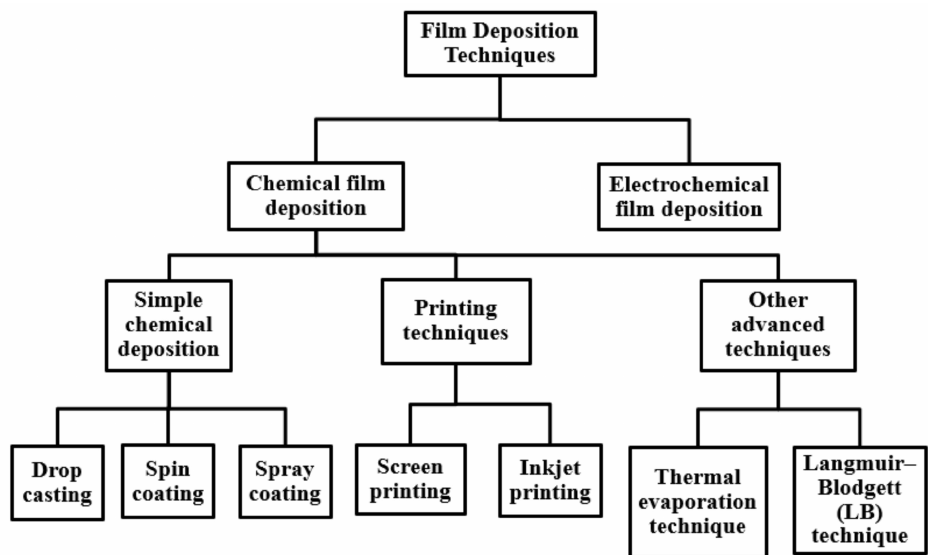
Figure 4. Types of film deposition